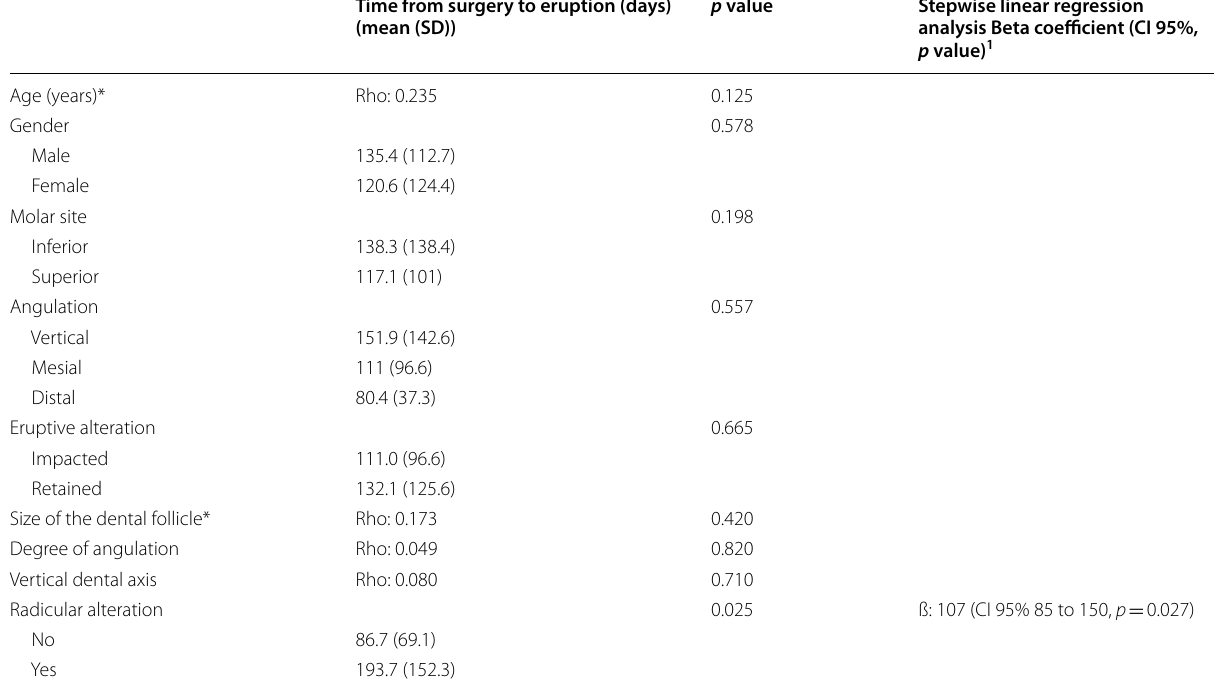
Table 3 Time between surgery and the appearance of the tooth in the mouth (days) according to sociodemographic and clinical variables. Bivariate and multivariate